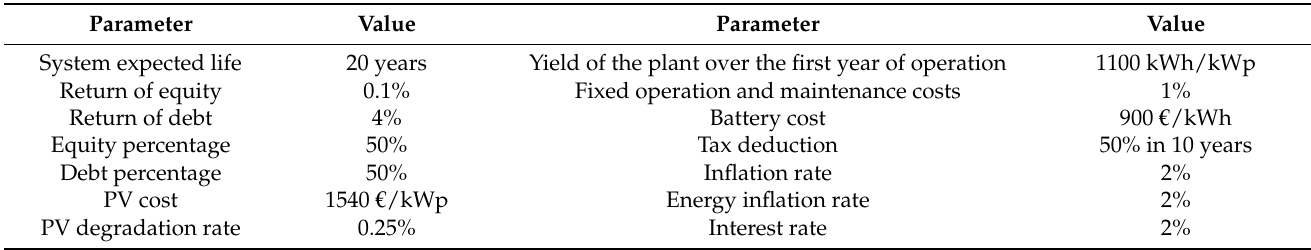
Table 5. Parameters for JARSC group economic